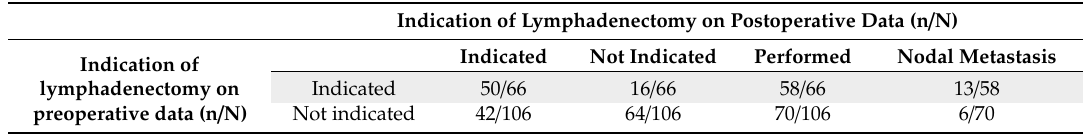
Table 6. Indication of lymphadenectomy and nodal metastases. Indication of Lymphadenectomy on Postoperative Data (n / N) Indicated Not